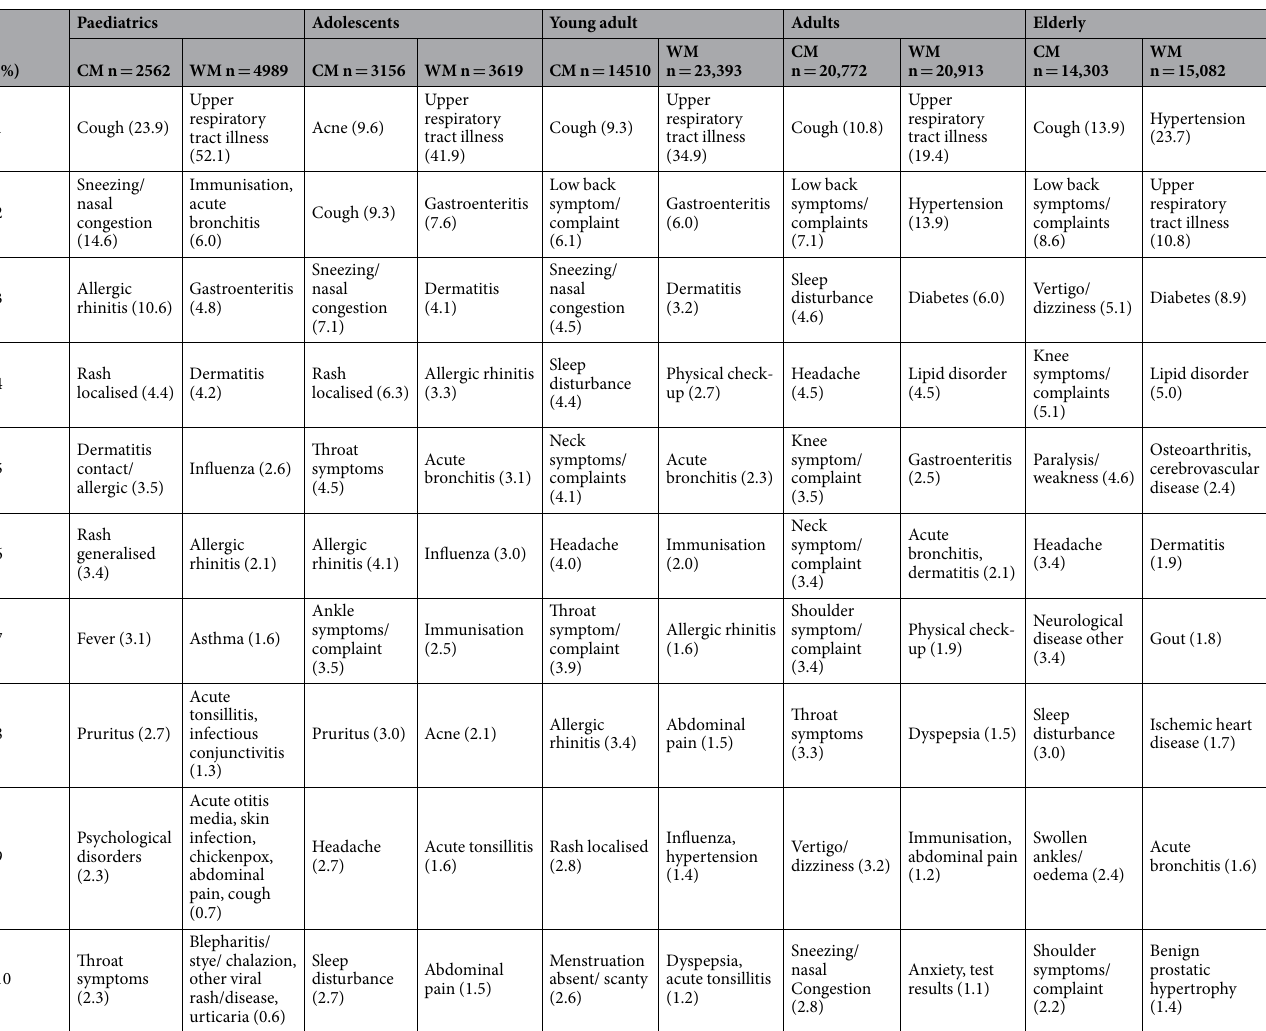
Table 5. Health problems encountered in Chinese and Western medicine 22 settings across different age groups. TCM, traditional Chinese medicine; WM, Western